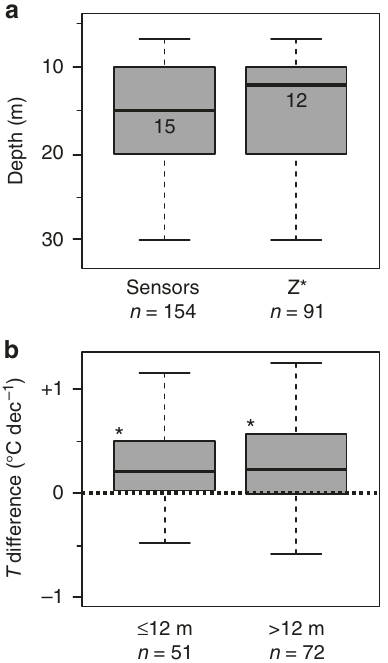
Fig. 6 Depth distribution of borehole temperatures. a Boxplots showing the depth distribution of temperature measurements (sensor depths) and of the zero annual amplitude Z * in the boreholes. b Temperature distribution in borehole sensors that are shallower ( ≤ 12 m) and deeper (>12 m) than the median of Z * . * indicate signi fi cant difference to 0, p < 0.05 de fi ned by the Wilcoxon Signed-Rank test; p values ≤ 12 m: 0.000, >12 m: 0.000 (rounded to three digits). The Kruskal – Wallis test between these zones ( b ) resulted in p = 0.908, indicating that the zones are not signi fi cantly different to each other. Boxplots represent 25 – 75% quartiles and whiskers are 1.5 interquartile ranges from the median. Medians are shown as black lines and labeled with values. The number of boreholes (sensors), and the number of available Z * values is indicated by